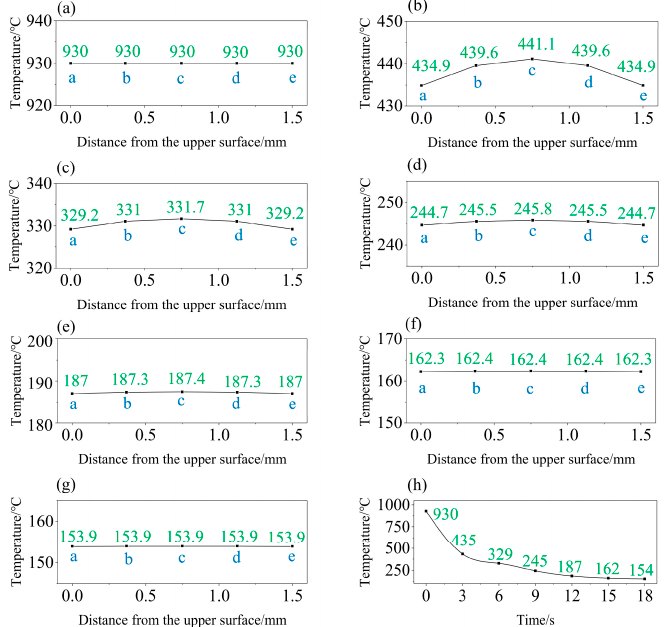
Figure 4. Temperature variation during quenching process: ( a ) 0 s, ( b ) 3 s, ( c ) 6 s, ( d ) 9 s, ( e ) 12 s, ( f ) 15 s, ( g ) 18 s and ( h ) temperature variation with time at location a.